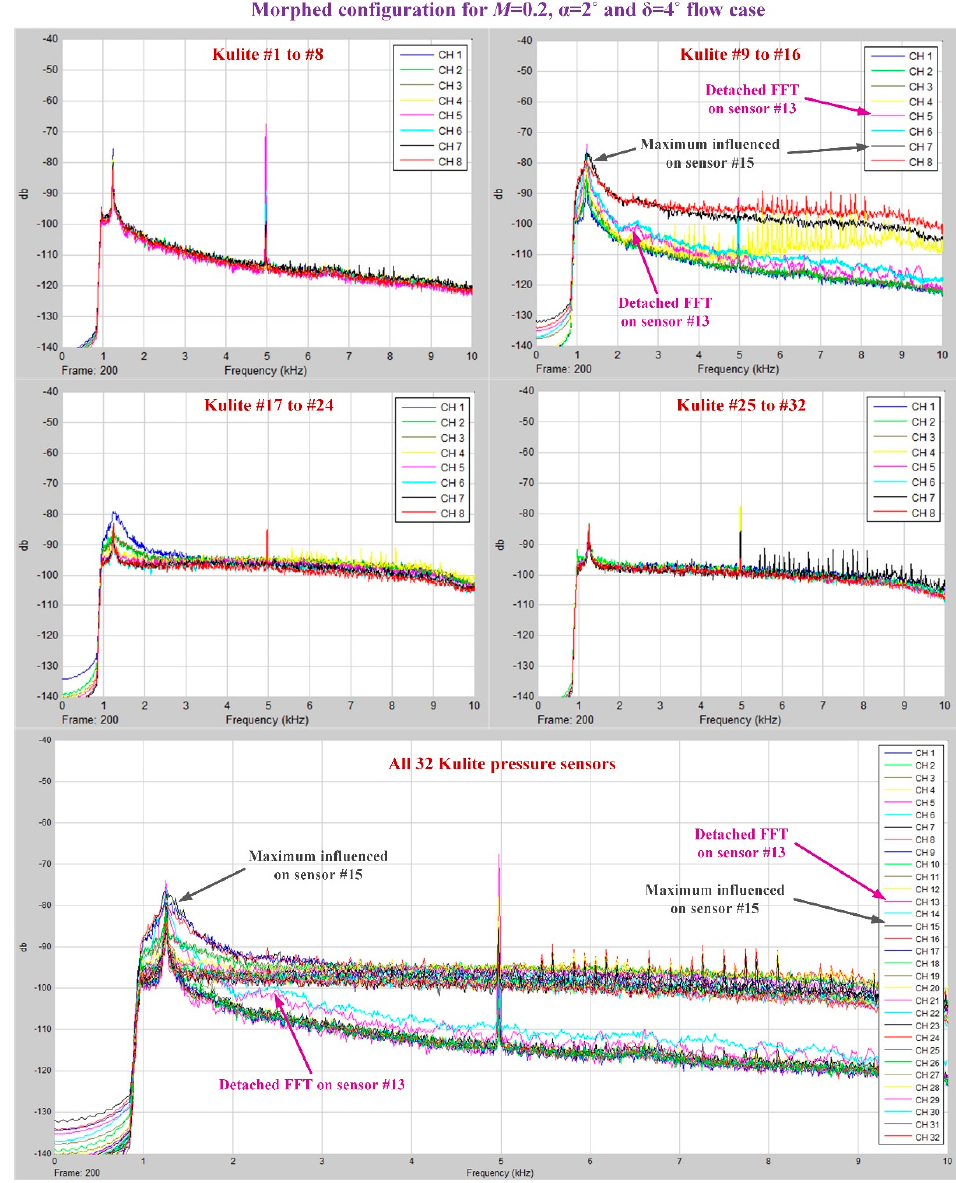
Figure 19. FFT results for the wing morphed configuration in M = 0.2, α = 2 ˚ , and δ = 4 ˚ flow conditions.